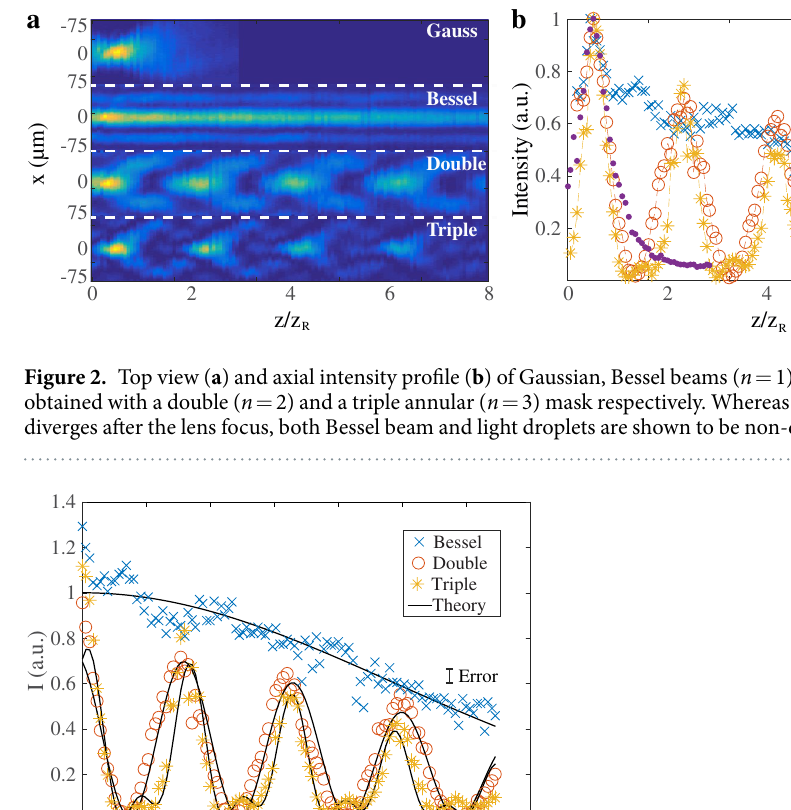
Z/zr Figure 3. Experimental data of the normalised beam intensity and their theoretical prediction (full curves) in the case of a simple Bessel-Gauss beam ( n = 1) (blue circles), two Bessel-Gauss beams ( n = 2) (red circles) and three Bessel-Gauss beams ( n = 3) (green